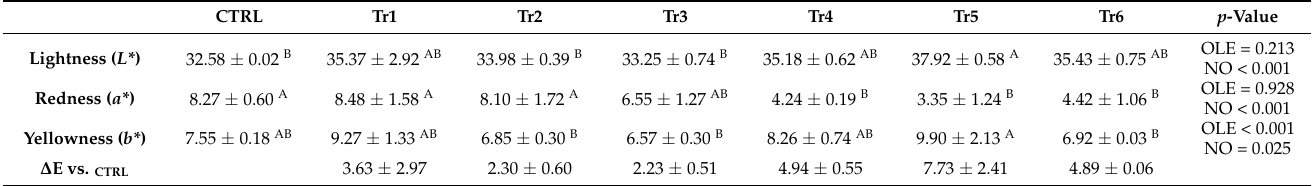
Table 5. Mean value, standard deviation, and results of the statistical analysis (two-way ANOVA) of the colour parameters of the ripened sausages under investigation ( n = 3).